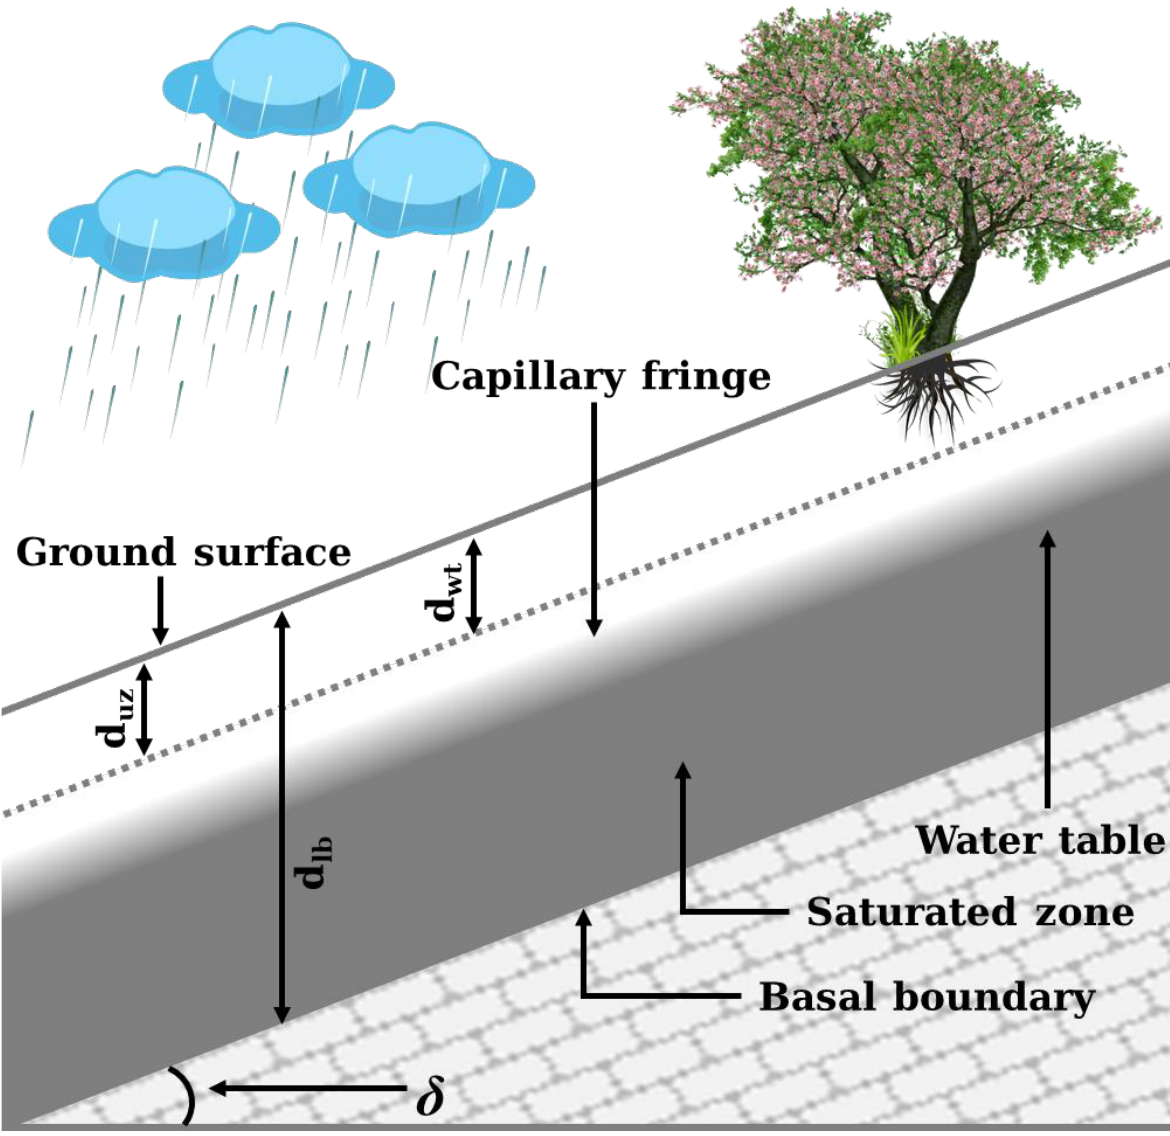
Figure 7. Schematic cross-section showing the shallow ground water condition in the soil. d uz is the unsaturated zone above the water table. d wt is the depth to the ground water table from the surface. d lb is the depth to the impervious lower boundary δ of the slope.